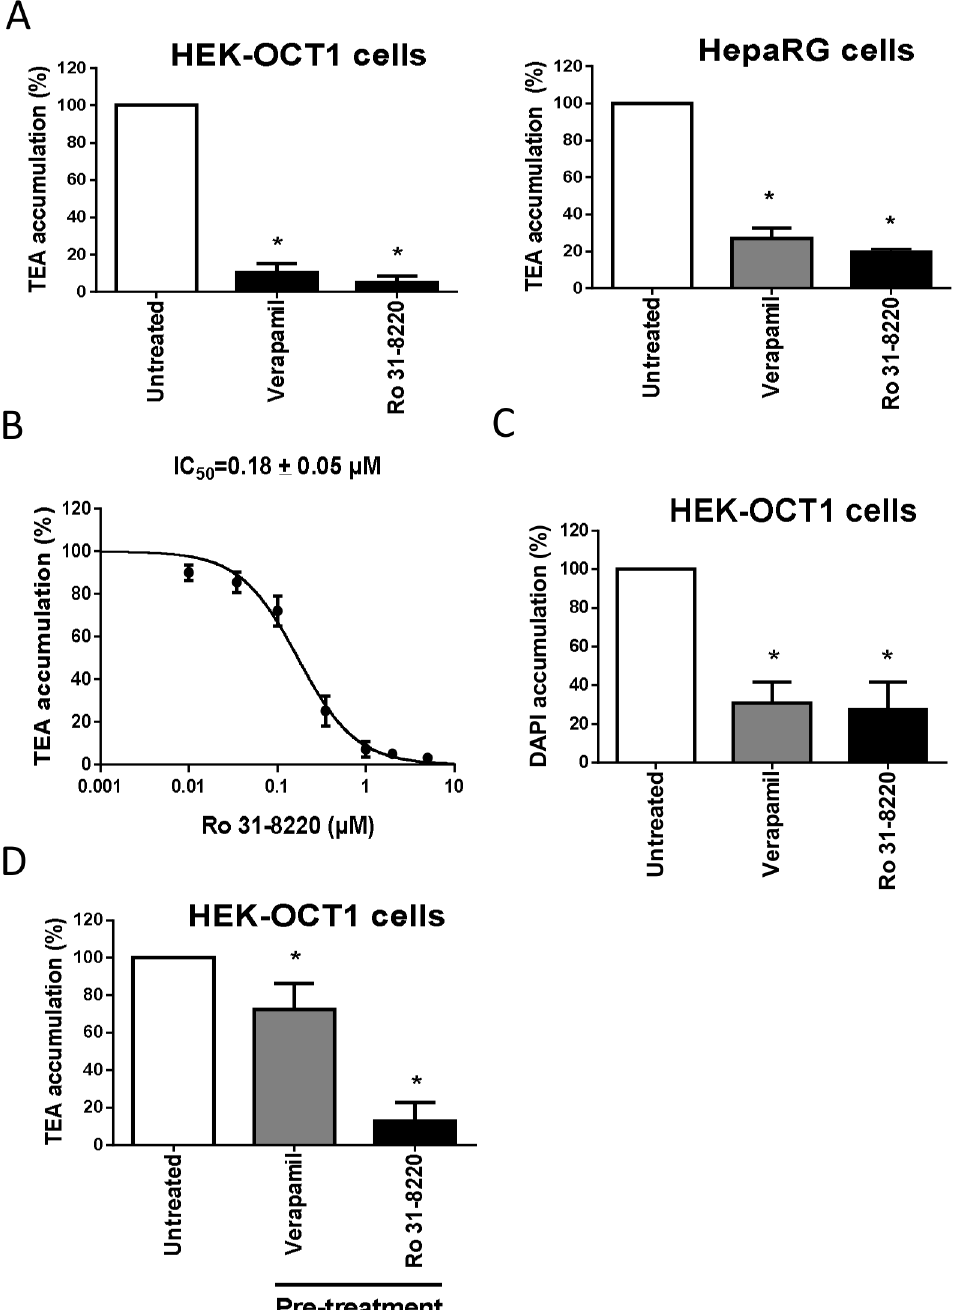
Fig 3. Direct cis-inhibition of OCT1 activity by Ro 31 – 8220. (A) HEK-OCT1 and HepaRG cells were incubated with 40 μ M [ 14 C]-TEA for 5 min at 37°C, in the presence or absence of 50 μ M verapamil or 2 μ M Ro 31 – 8220. After washing with ice-cold PBS, intracellular accumulation of TEA was determined by scintillation counting. Data are expressed as % of accumulation of TEA found in control cells, set at 100%, and are the means ± SEM of at least three independent experiments. * , p < 0.05 when compared with untreated cells (ANOVA followed by Dunnett's post-hoc test). (B) HEK-OCT1 cells were incubated with 40 μ M [ 14 C]-TEA for 5 min at 37°C, in the presence of various concentrations of Ro 31 – 8220 (from 0 to 10 μ M). After washing with ice-cold PBS, intracellular accumulation of TEA was determined by scintillation counting. Data are expressed as % of accumulation of TEA found in control cells, set at 100%, and are the means ± SEM of four independent experiments. Ro 31 – 8220 IC 50 value is indicated at the top of the graph. (C) HEK-OCT1 cells were incubated with 1 μ M DAPI for 5 min at 37°C, in the presence or absence of 50 μ M verapamil or 2 μ M Ro 31 – 8220. After washing with ice-cold PBS, accumulation of DAPI was determined by spectrofluorimetry as described in Materials and Methods. Data are expressed as percentage of DAPI accumulation in control cells and are the means ± SEM of four independent experiments. * , p < 0.05 when compared with untreated cells (ANOVA followed